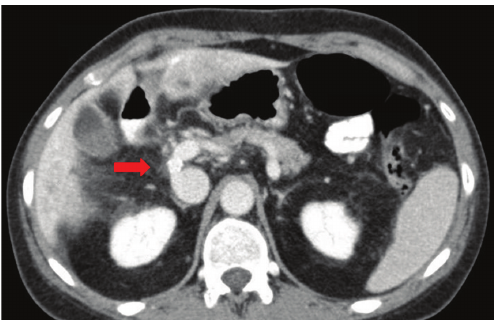
Figure 4: CT abdomen with IV contrast two weeks following sur- gical portacaval shunt placement. An 8mm polytetrafluorethylene (PTFE) graft connects the main portal vein with infrahepatic infe- rior vena cava (red